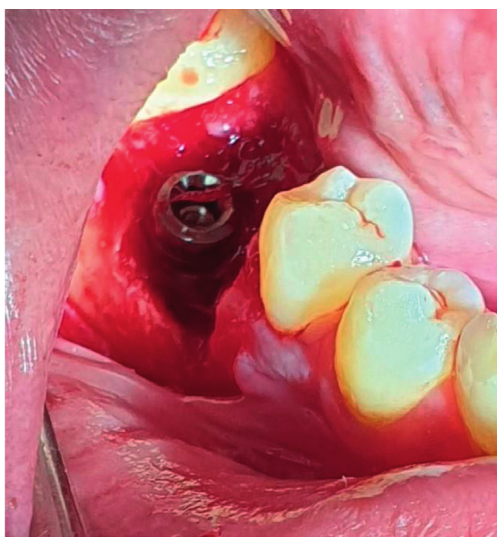
Figure 3: The implant fixture was placed 3-4 mm below the labial gingival margin.